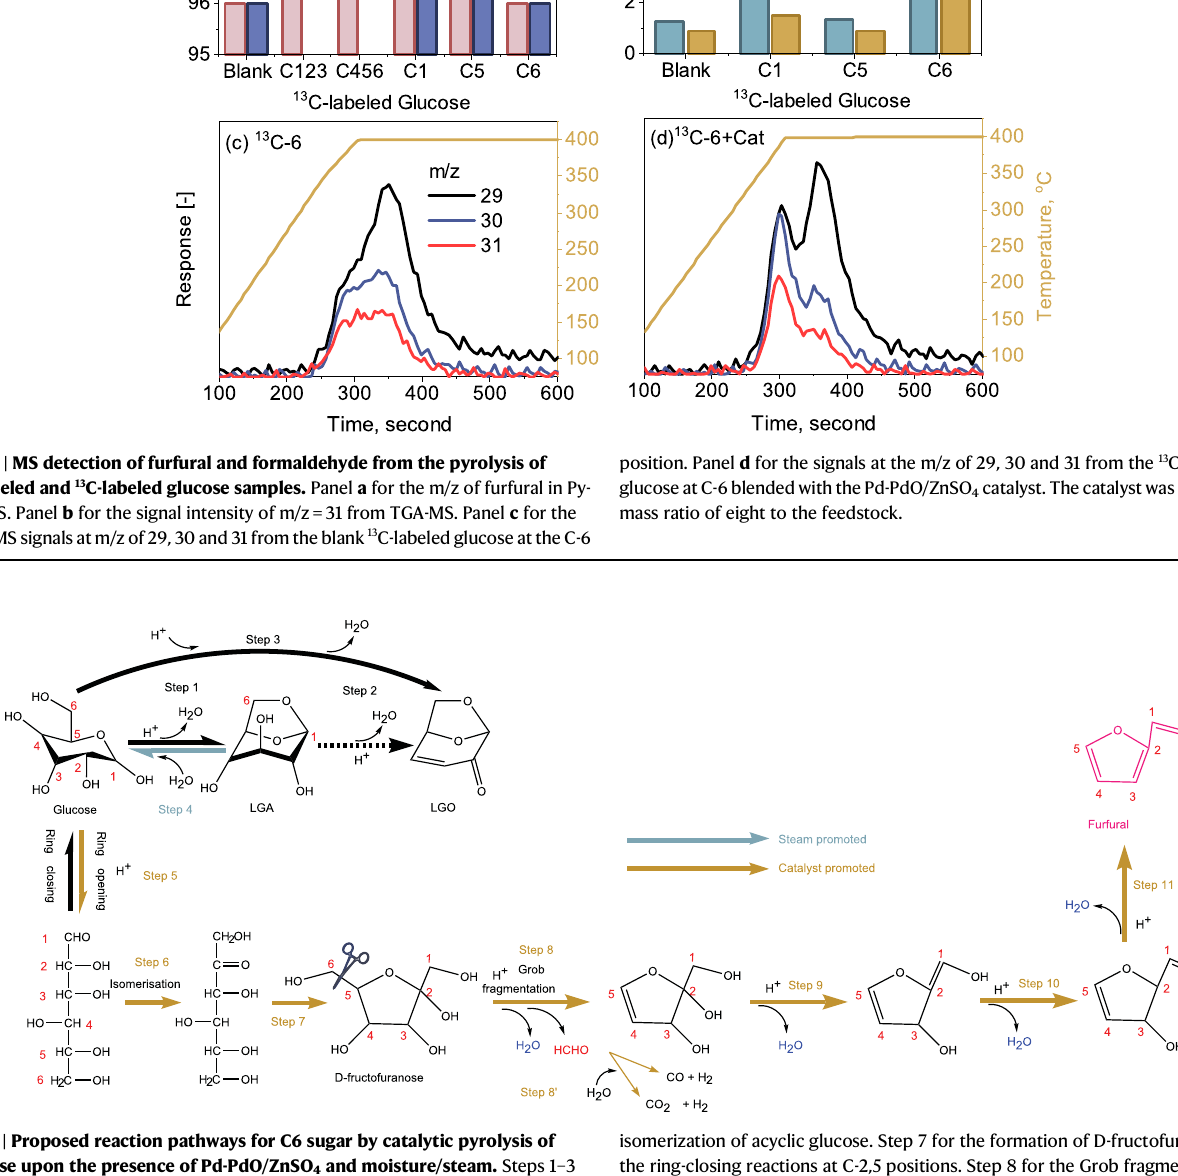
Fig. 7 | Proposed reaction pathways for C6 sugar by catalytic pyrolysis of glucose upon the presence of Pd-PdO/ZnSO 4 and moisture/steam. Steps 1 – 3 refer to dehydration ofglucose to LGAand/or LGO uponthermal shock.Step 4 for the hydrolysis of LGA upon the promotion of added moisture from wet glucose. Step 5for the creation of acyclicglucose viaaring-opening reaction.Step6forthe